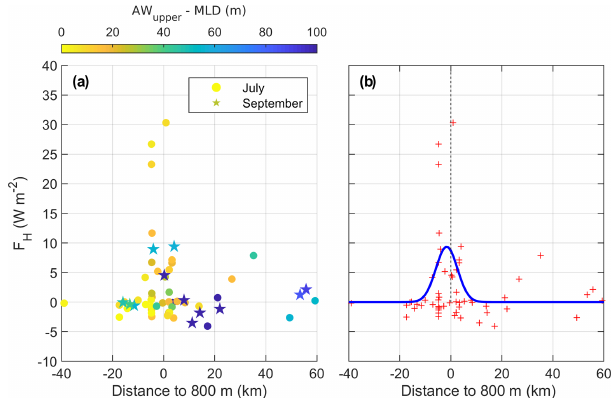
Figure 9. (a) Lateral distribution of the mean vertical turbulent heat flux from the AW upper boundary to the base of the mixed layer. The horizontal axis is the horizontal distance to the 800m isobath. The color code is the vertical distance between the upper boundary of the Atlantic Water layer and the mixed layer depth. Markers iden- tify the stations collected in July (circles) and September (stars). (b) A Gaussian fit (blue line) to the vertical turbulent heat flux from the Atlantic Water to the mixed layer depth (red